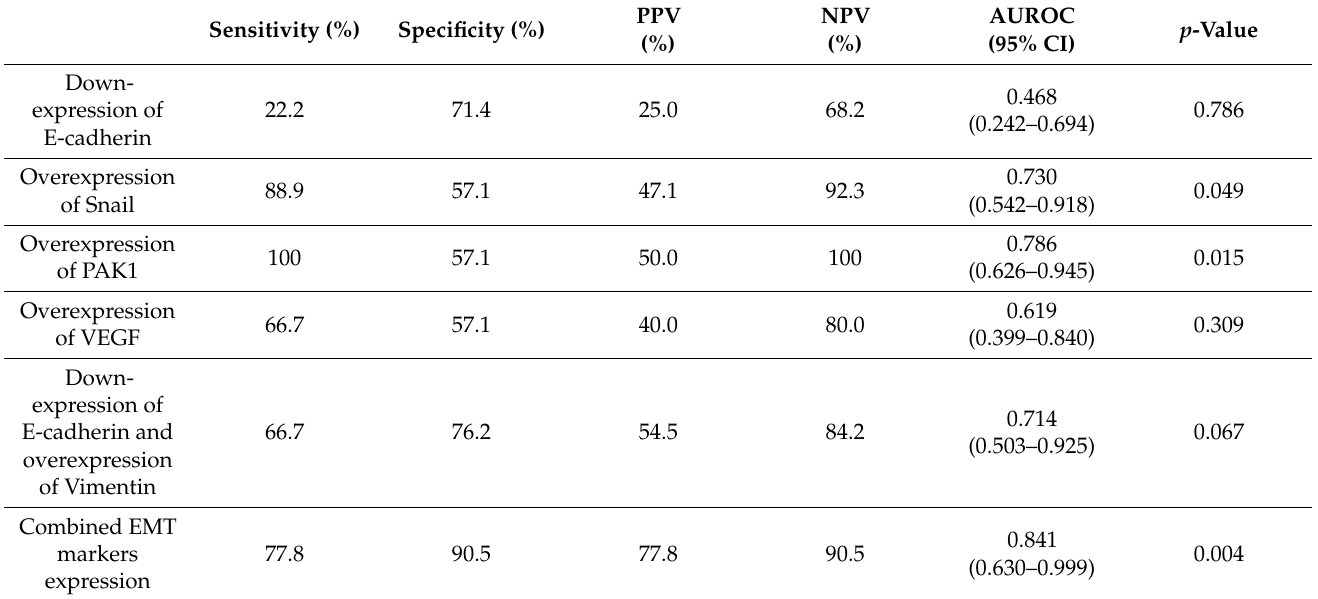
Table 3. Sensitivity and specificity of EMT markers for prediction of MVI in patients with HCC.